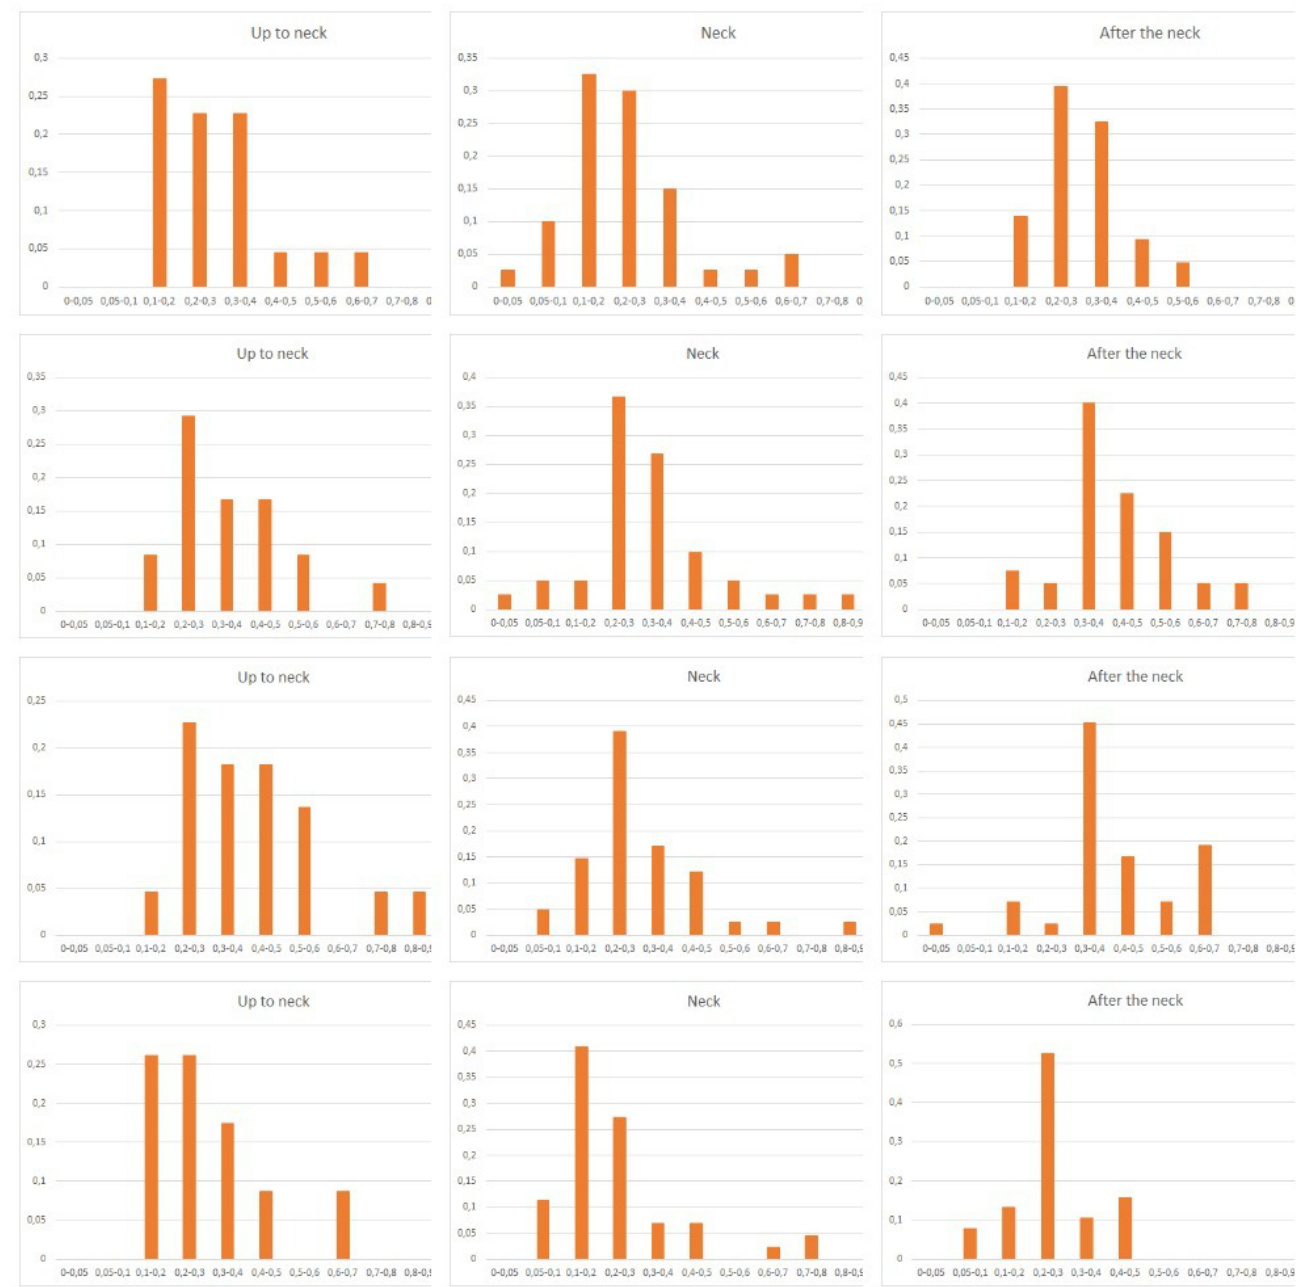
Figure A2. Histograms of ∆ WSS distribution over the stent surface of Patient